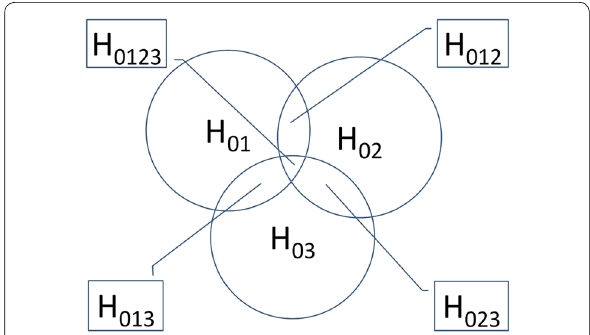
Fig. 1 Illustration of the CP. Main null hypotheses H 0 i : µ 0 = µ i and intersection